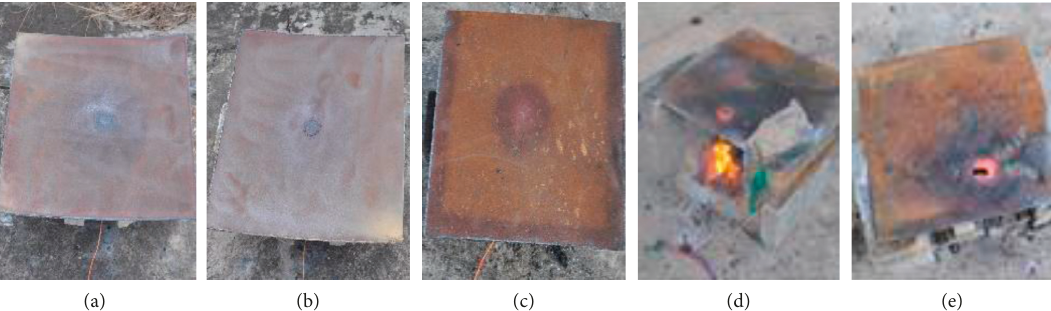
Figure 3: The resulting steel plates ablated by thermite. (a) 1#. (b) 2#. (c) 3#. (d) 4#. (e)